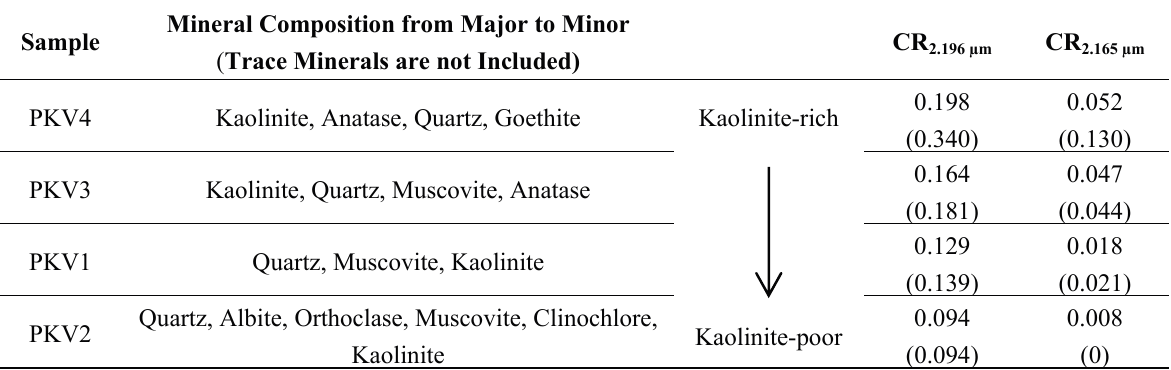
Table 2. The mineralogy of land samples according to XRD analysis and samples with their CR and CR values as calculated from the SWIR reflectance image (in parentheses 2.196µm 2.165µm are the values from the laboratory measurements with the ASD